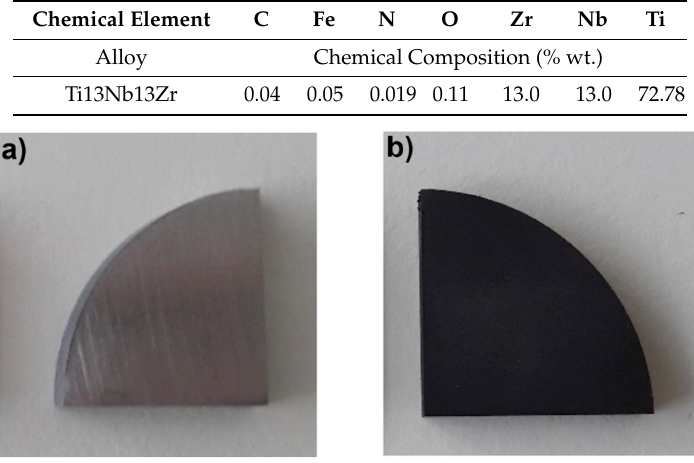
Figure 1. Alloy sample surfaces after ( a ) abrasive treatment and ( b ) etching in 5% hydrofluoric acid (HF). Table 1. Chemical composition of Ti13Nb13Zr titanium alloy in % by weight.